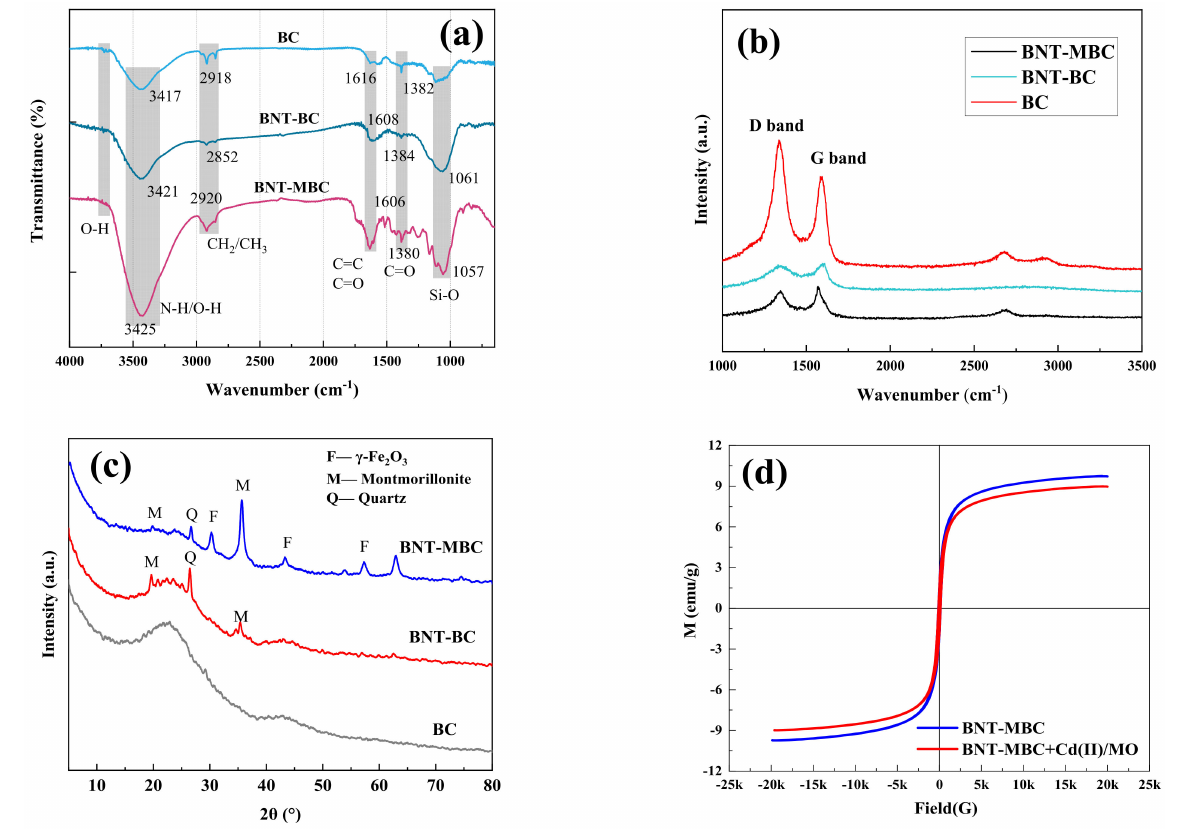
Figure 2. ( a ) FTIR spectra of BC, BNT-BC, and BNT-MBC; ( b ) Raman spectra of BC and BNT-MBC; ( c ) XRD of biochar of BC, BNT-BC, and BNT-MBC; ( d ) Hysteresis loop of BNT-MBC before and after